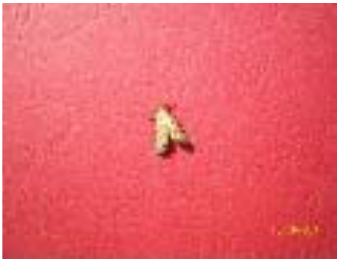
Figure 7. Image of Cnaphalocrocis medinalis Guenee